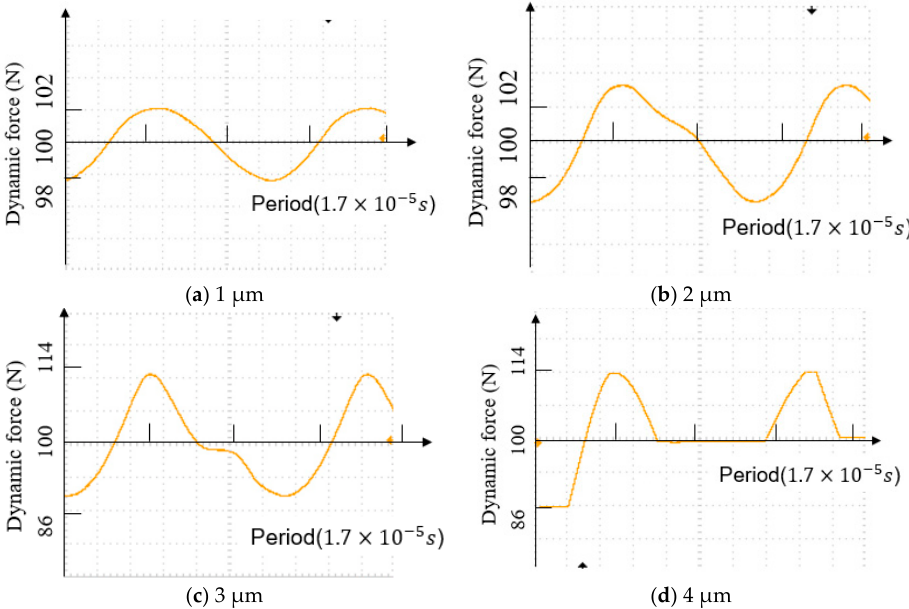
Figure 6. Waveform of dynamic oscillatory forces during compression with different ultrasonic amplitudes.